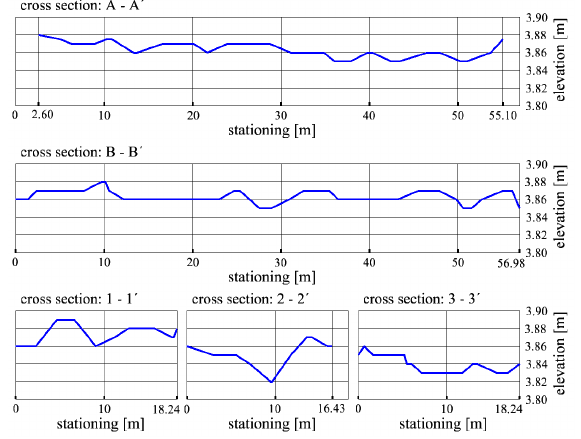
Figure 10. The vertical course of longitudinal and vertical cross sections of the 2 nd AGL floor